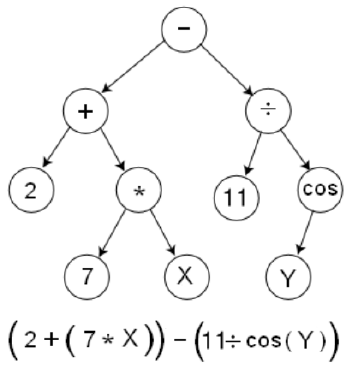
Figure 4. The parse tree and the encoded expression.